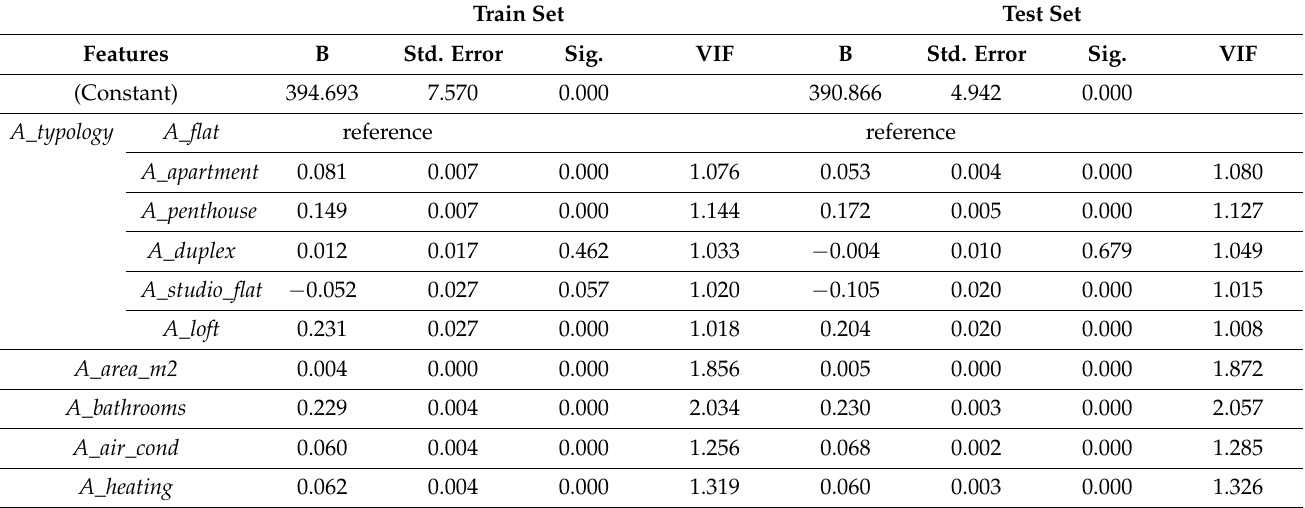
Table A1. Summary of the results of the OLS regression model using dummy variables, for the training and test